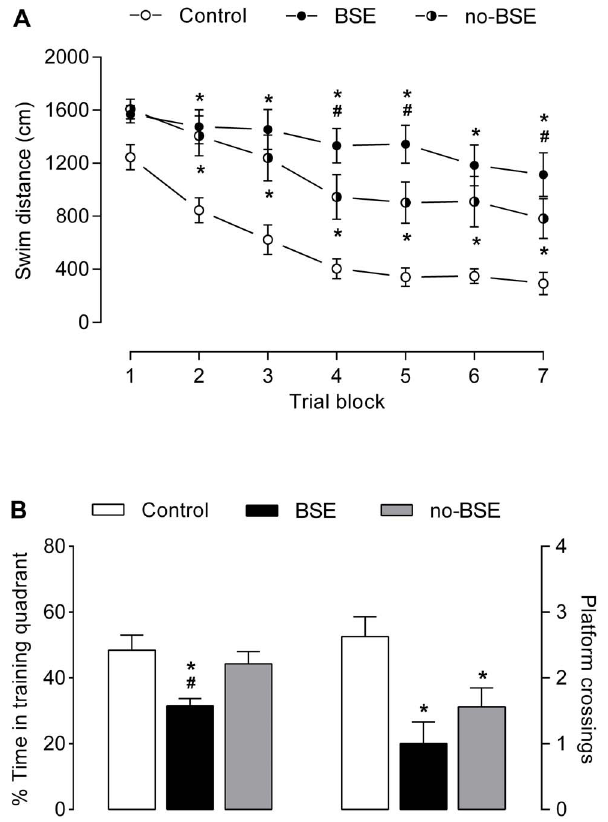
Figure 4. Effects of kainate treatment on the performance of rats on the water maze. ( A ) The y-axis represents the mean swim distance ( 6 SEM) in centimeters to reach a hidden platform throughout the acquisition of the water maze task. The data were averaged across seven blocks of four consecutive trials each (the x-axis). Note that the performance of rats that had experienced behavioral status epilepticus (BSE group) on this task was extremely poor. However, spatial learning of the rats that showed no convulsive status epilepticus (no-BSE group) was also considerably impaired. * p , 0.0001 for BSE group vs. control group and p , 0.001 for no-BSE group vs. control group; # p , 0.05 vs. no- BSE group. ( B ) The y-axes represent the percentage of time spent by rats in the training quadrant of the water maze during the probe trial and the number of times they swam through the zone where the platform had been located (platform crossings). Unlike control rats, rats in the BSE group did not show a preference for the training quadrant of the water maze and were impaired in their ability to localize the former platform position. However, the acuity of spatial search was also impaired in the no-BSE rats, as indicated by the fact that they crossed the former platform position less frequently than did control rats. * p , 0.05 for no-BSE group vs. control group and p , 0.01 for BSE group vs. control group; # p , 0.05 vs. no-BSE group. Data are presented as the mean 6